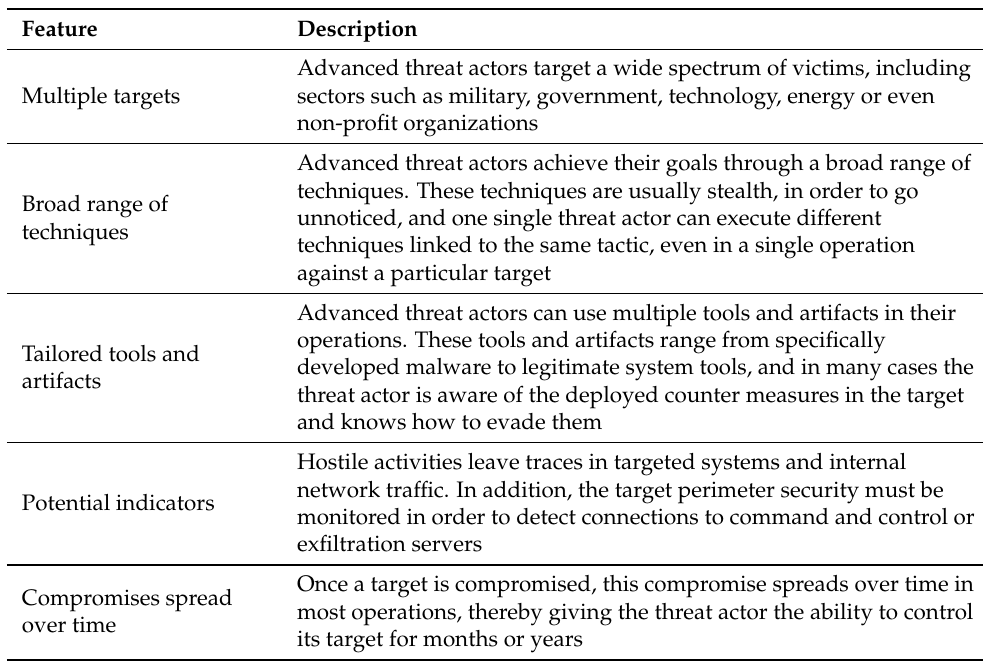
Table 2. Key features in offensive